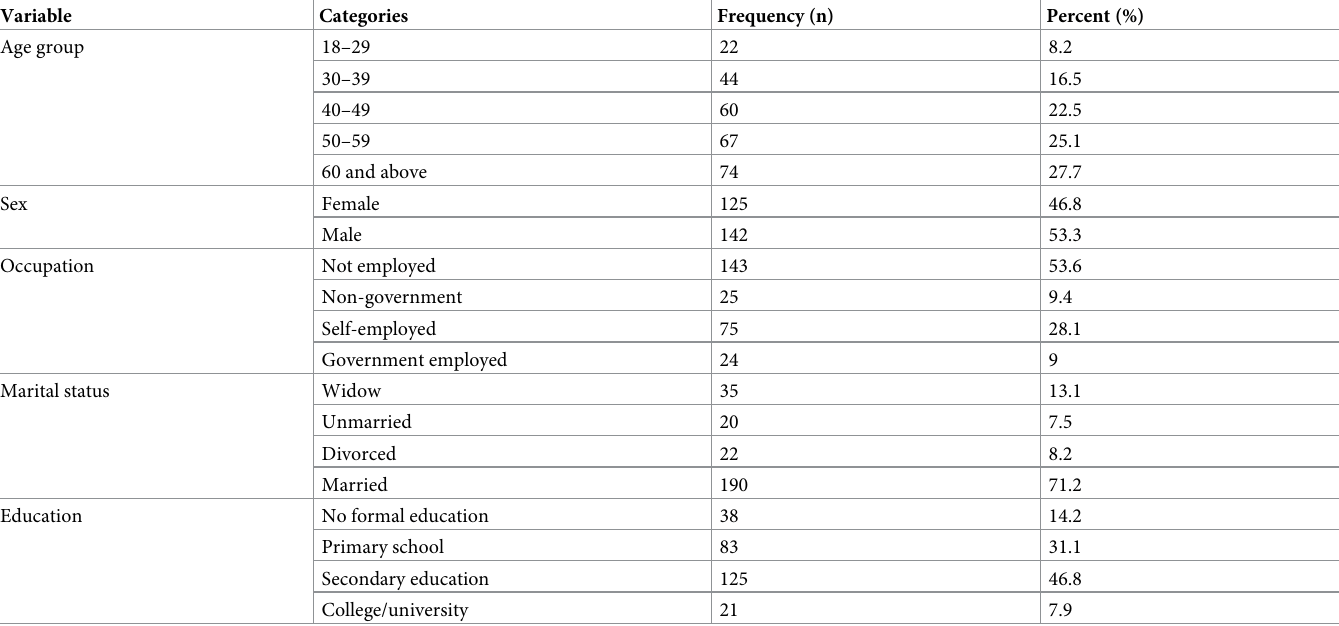
Table 1. Socio-demographic characteristics of patients attending the diabetic Clinic at Mnazi Mmoja Referral Hospital.